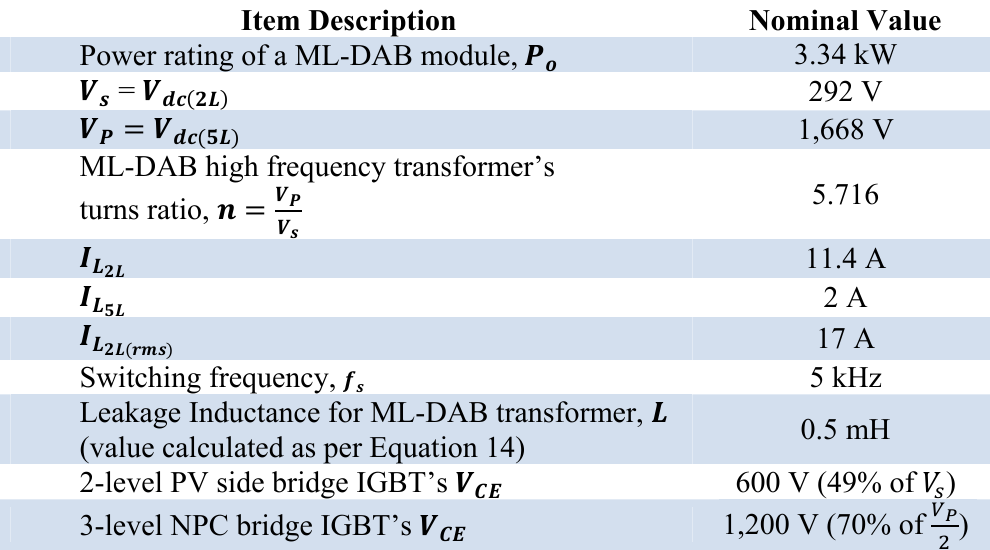
; (cid:3028)(cid:3029)